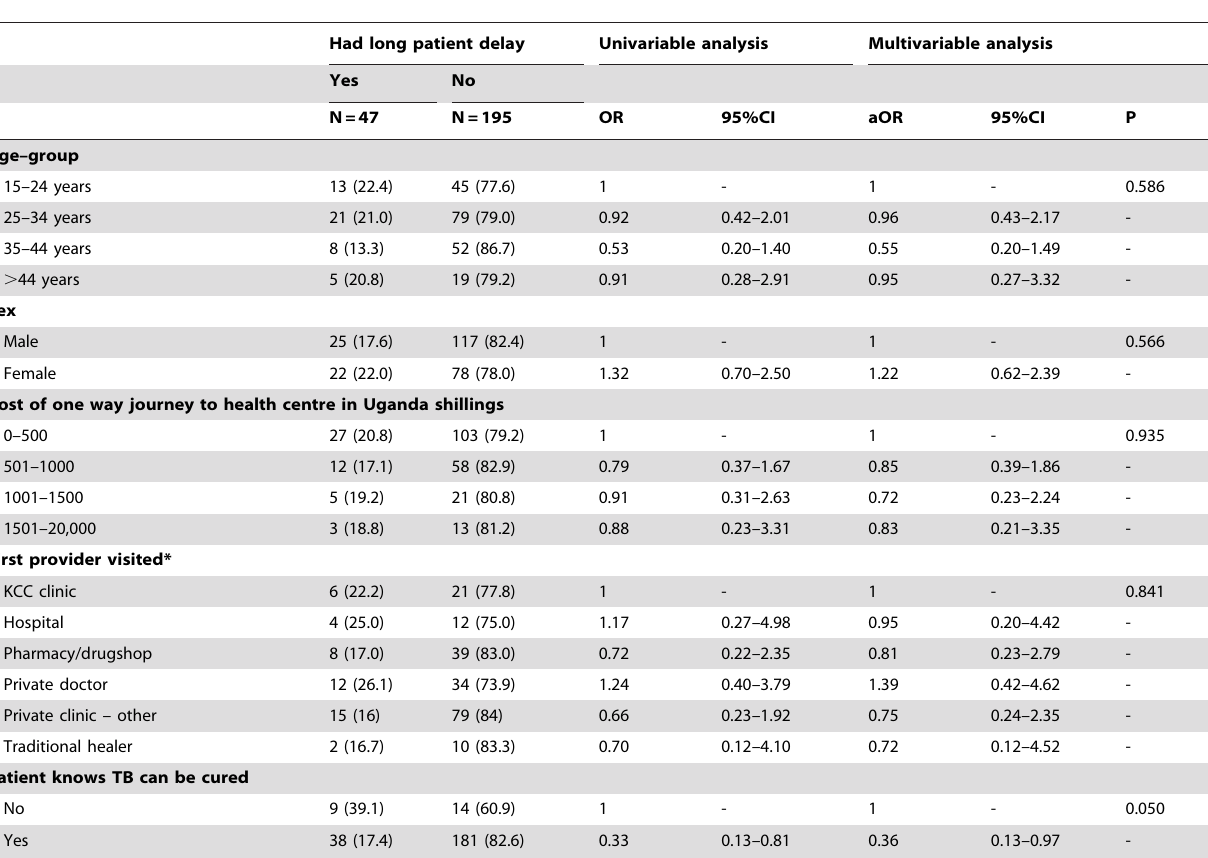
Legend *= Data available for only 239; KCC = Kampala City Council; OR= Odds ratio; aOR= adjusted odds ratio; CI= Confidence interval; TB=